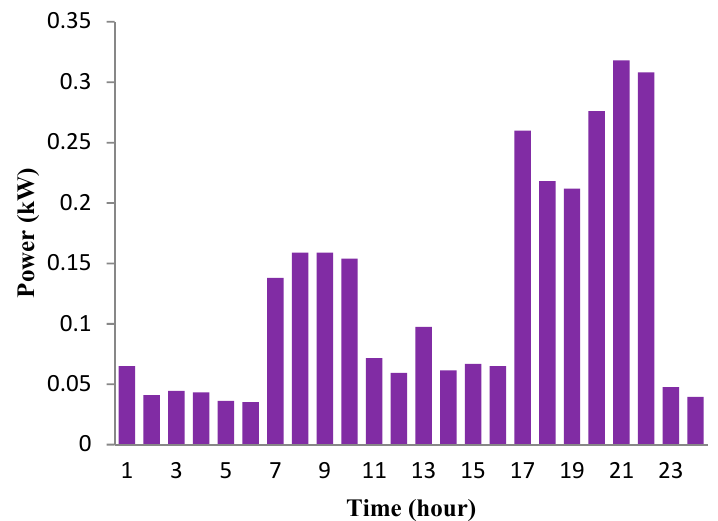
Figure 7. Predicted load profile of a house during o ff -peak hours over a 24 h horizon.